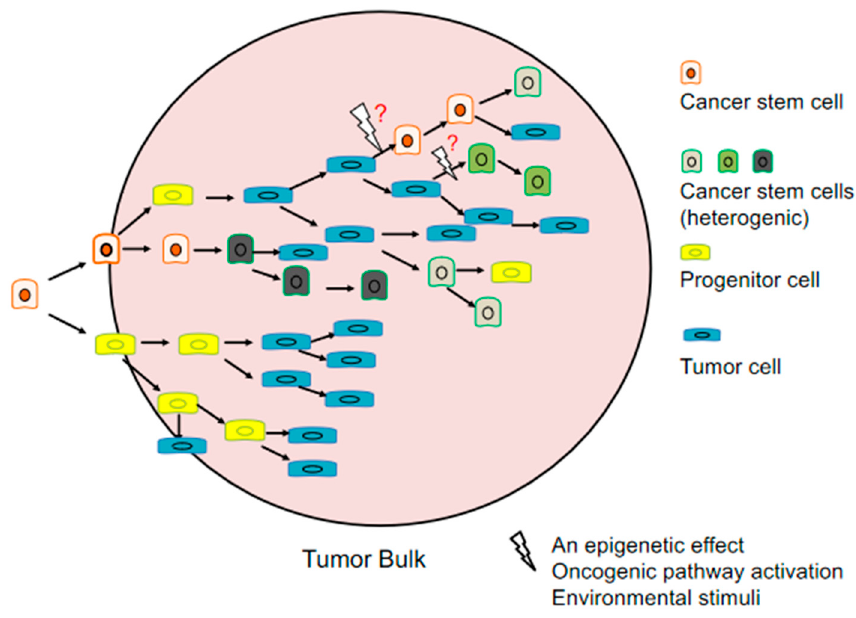
Figure 1. Origin and heterogeneity in cancer stem cell model; Cancer stem cells (CSCs) can form progenitor and cancer stem cells and can differentiate to cancer cells. When an appropriate epigenetic effect, oncogenic pathway activation or environmental stimuli event occur, differentiated cancer cells can transform to cancer stem cell.